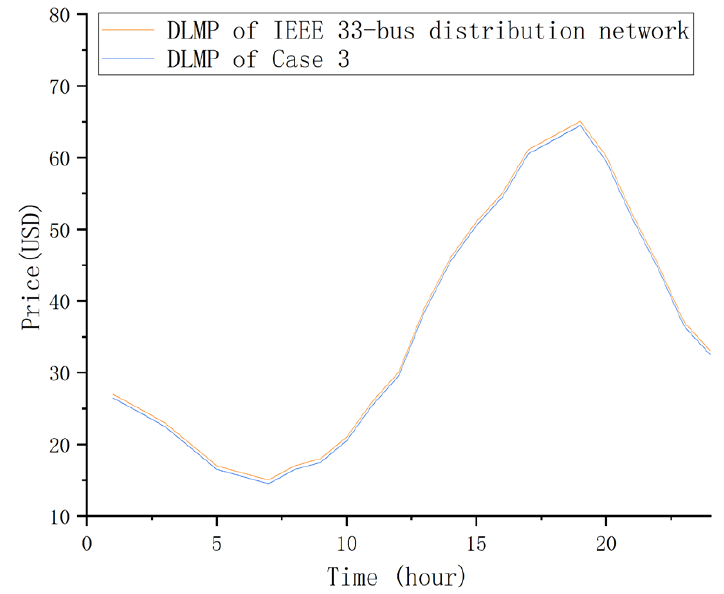
Figure 4. DLMP curve of node 2 in IEEE 33-bus distribution network and Case 3. Figure 5a represents the time-varying electricity price and charging/discharging power of the BSS in Case 2. The electricity price is in line with the supply and demand relationship with electricity consumption and decreases with the load reduction in the morning and late at night. The BSS charges when the electricity price is low (5:00–7:00) and discharges larger amounts when the electricity price is high (17:00–19:00) to reduce the cost of electricity purchases. Due to the existence of standby batteries, BSS uses the spare batteries for low storage and high-power generation with the power grid to realize arbitrage and obtain additional income beyond the power exchange